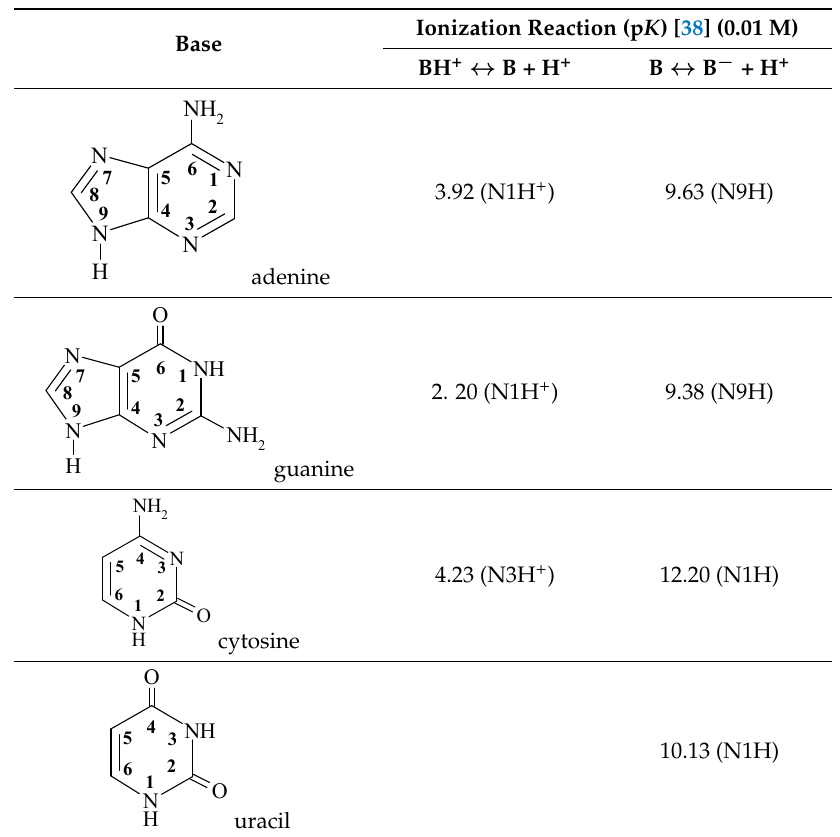
Table 1. Ionization constants of nucleic acid bases.